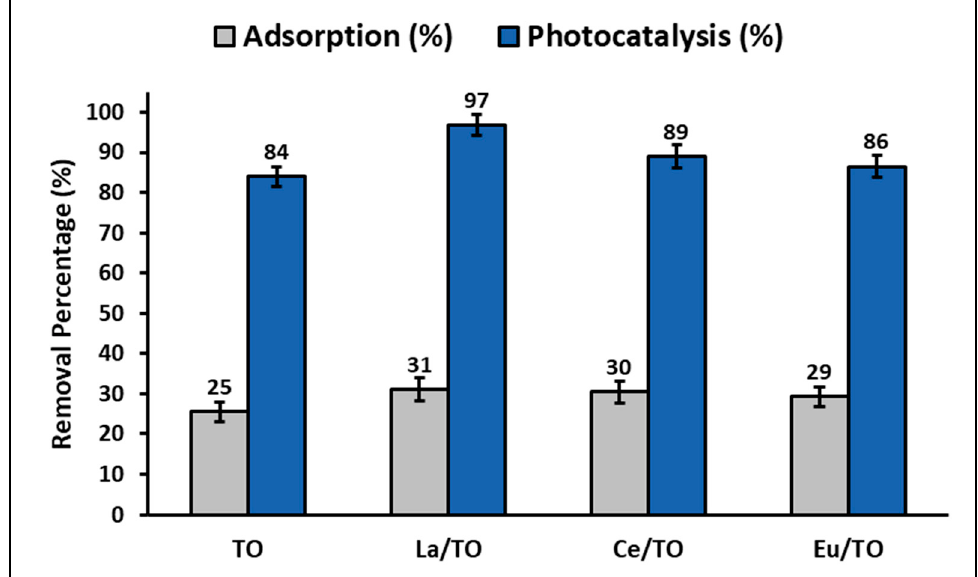
Figure 13. Percentage of cyanide adsorbed and photodegraded by Figure 13 . Percentage of cyanide adsorbed and photodegraded by nanoparticles .